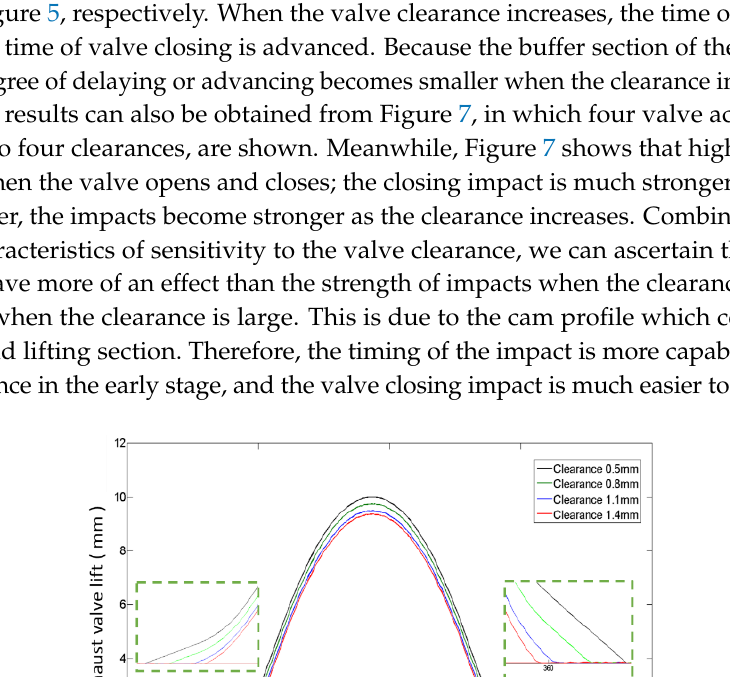
Figure 6. The relationship between valve clearance and the timing of valve closing. Figure 7. Valve acceleration of different clearances. Figure 8. Valve acceleration of different speeds.